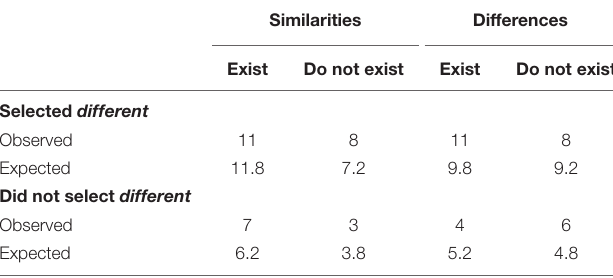
TABLE 4 | The Relationship between biological factors and conceptual understanding ( N = 29). Similarities